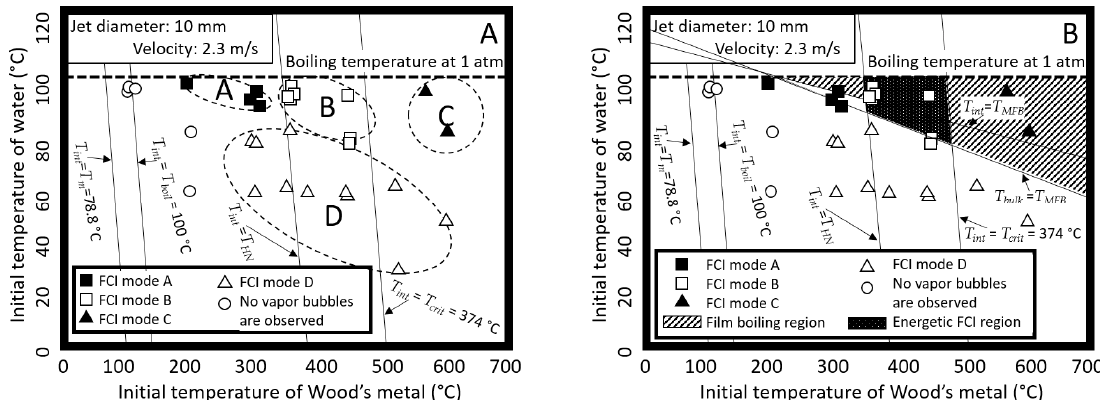
Figure 5. Influence of temperature of coolant (Y-axis) and melt (X-axis) on (adapted from Reference [57]): ( A ) Fuel Coolant Interaction modes assigned to the experimental data points; ( B ) the same data set with film boiling region indicated (according to minimum film boiling temperature model ( T MFB -model)). In these graphs: T int is the interface temperature; T m and T bulk are the melting temperature and the bulk temperature of the hot phase; T boil , T HN , T crit , and T MFB are the boiling temperature, the homogeneous nucleation temperature, the critical temperature, and the minimum film boiling temperature of the coolant.